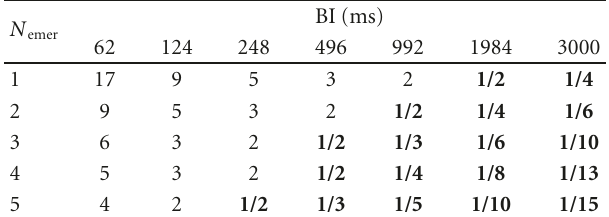
Table 1: Breakpoint of EGTS superrate to